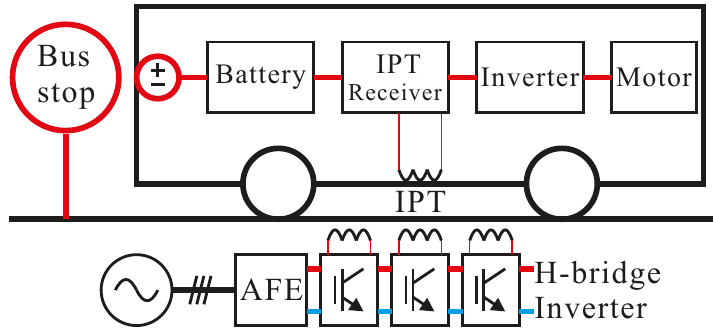
Figure 1. Inductive power transfer system for bus ‐ stop ‐ powered EVs or hybrid EVs.